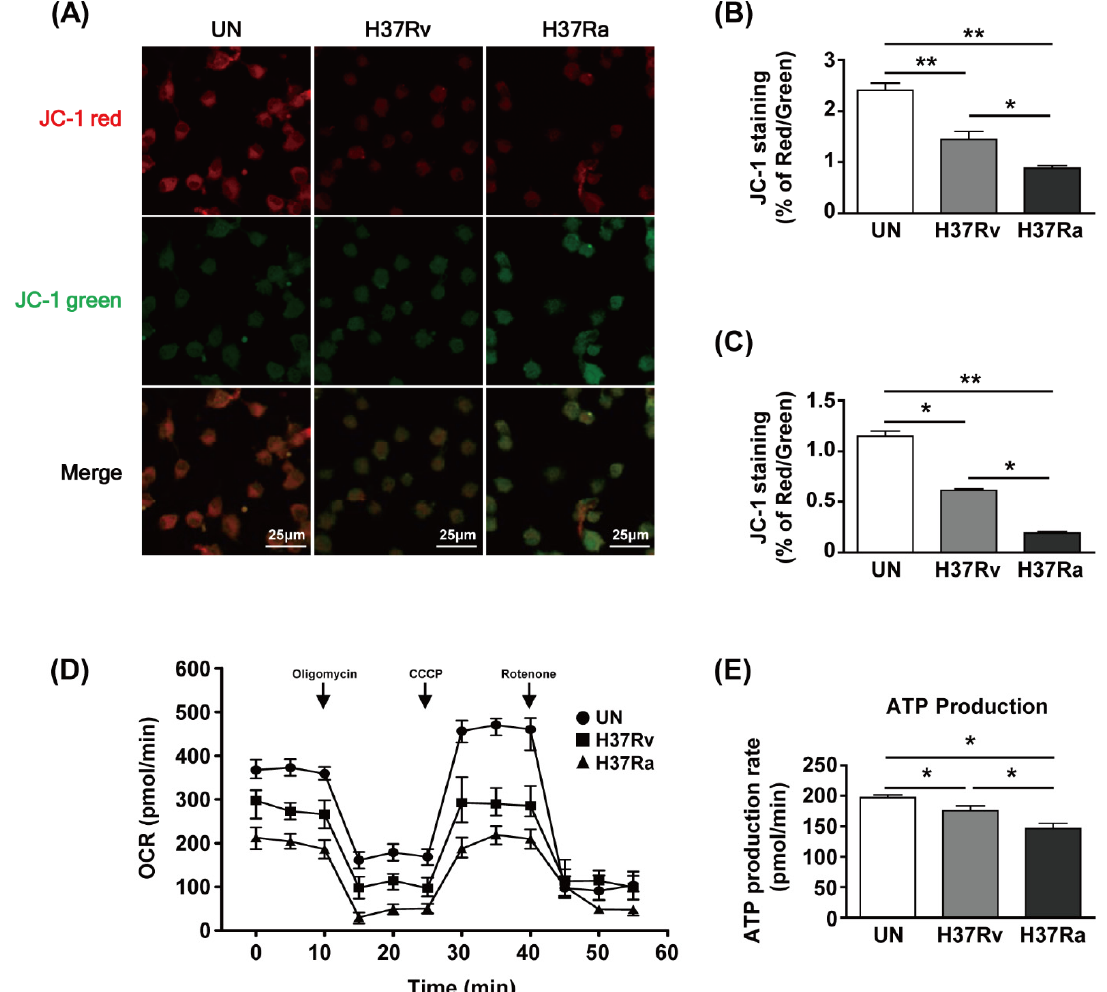
Figure 1. Mycobacterium tuberculosis (Mtb) increases mitochondrial dysfunction in macrophages. Bone marrow-derived macrophages (BMDMs) were infected with Mtb H37Rv (Rv) or Mtb H37Ra (Ra) (MOI = 1) for 3 h and incubated for 24 and 48 h. Mitochondrial membrane potential in BMDMs was assessed by JC-1 staining. Fluorescence of JC-1 was detected at an excitation wavelength of 488 nm and an emission wavelength of 530 nm by ( A ) confocal microscopy or ( C ) flow cytometry. ( B ) Quantification of the red-to-green ratio in ( A ). ( D ) Oxygen consumption rate (OCR) after sequential treatment with oligomycin, carbonyl cyanide 3-chlorophenylhydrazone (CCCP), and rotenone. ( E ) ATP production in Mtb-infected BMDMs. ATP production rate was calculated from OCR measured in the XF24 Extracellular Flux Analyzer. Data are means ± SD of three independent experiments. * p < 0.05, ** p < 0.01.